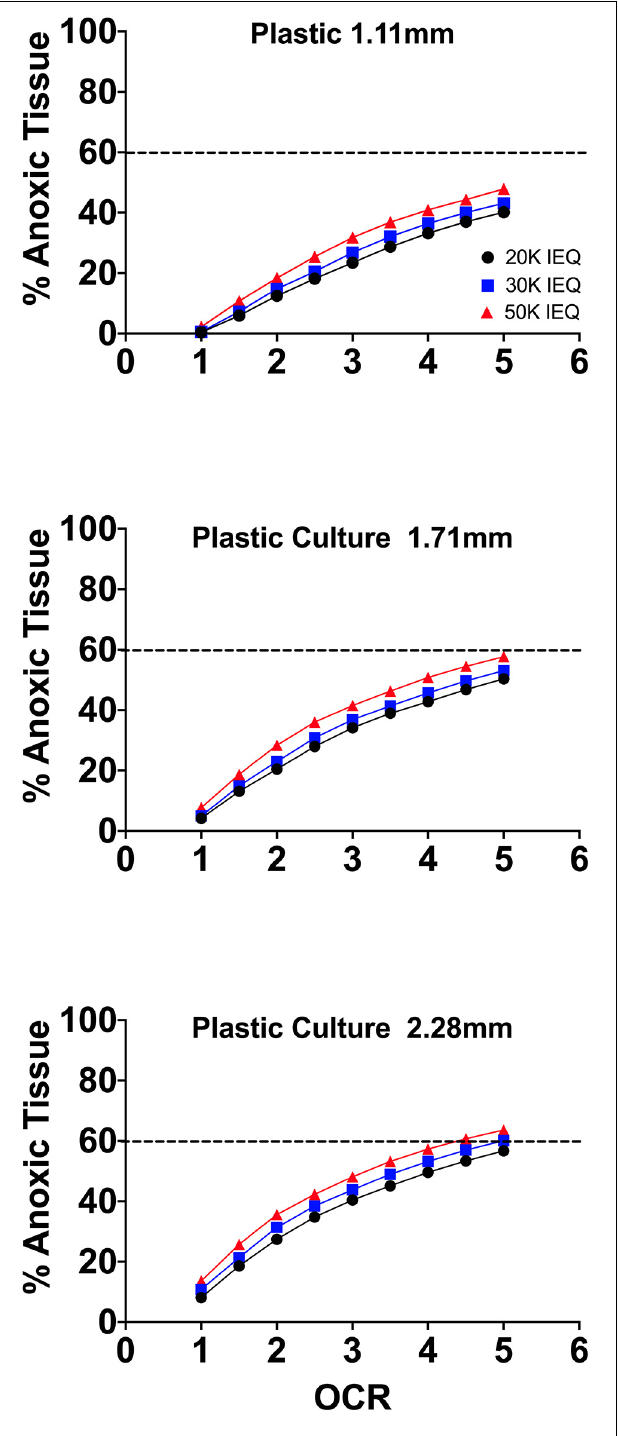
FIGURE 2 | FEM results of islet spheroids in standard culture (95% RA/5% CO 2 ; plastic surface; 37 ◦ C) with varied seeding density and culture medium height across the range of reported islet oxygen consumption rate. Tissue anoxia is observed, primarily in IEQ sizes > 100 µ m, even at low oxygen consumption rates and is significantly affected by culture medium height ( ∼ (cid:49) 20% min to max) and increased OCR ( ∼ (cid:49) 50% min to max) and less so by seeding density ( ∼ (cid:49) 7% min to